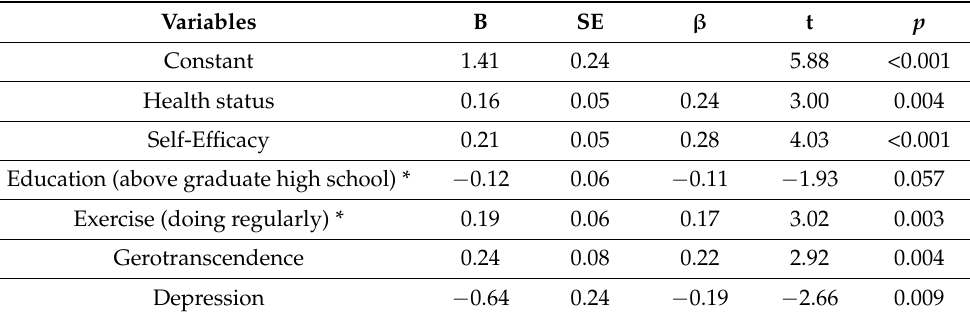
Table 4. Factors affecting the healthy aging of subjects.